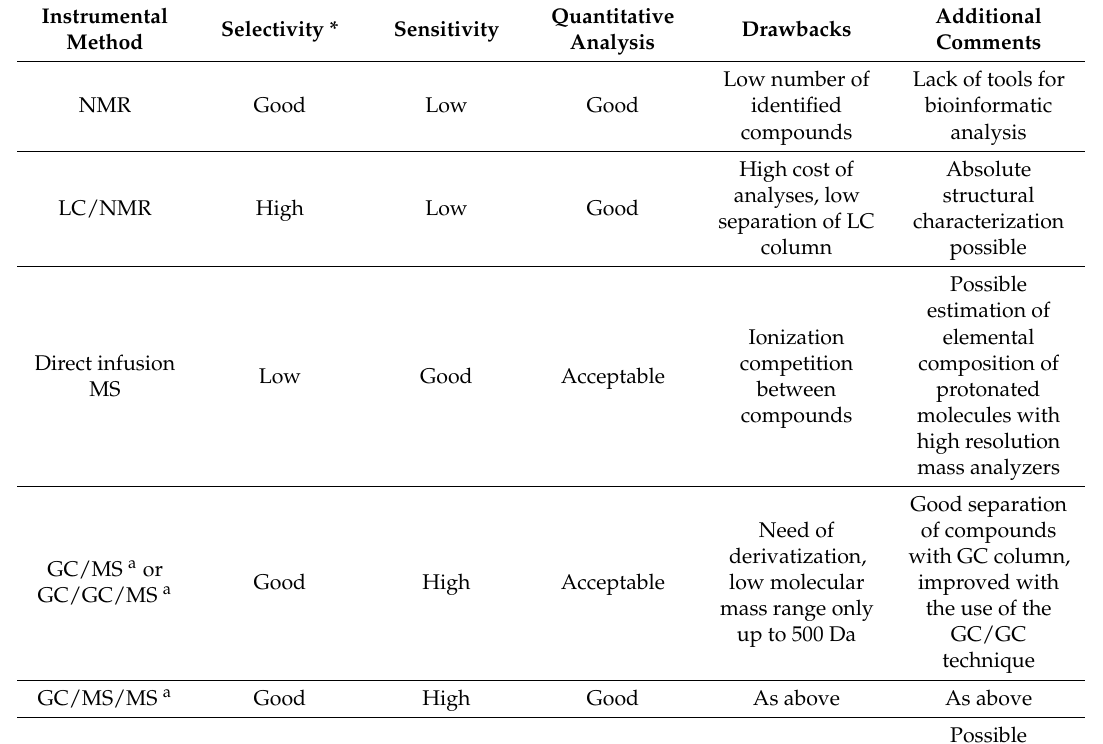
Table 1. Limitations and benefits of nuclear magnetic resonance and mass spectrometric instruments in metabolomic